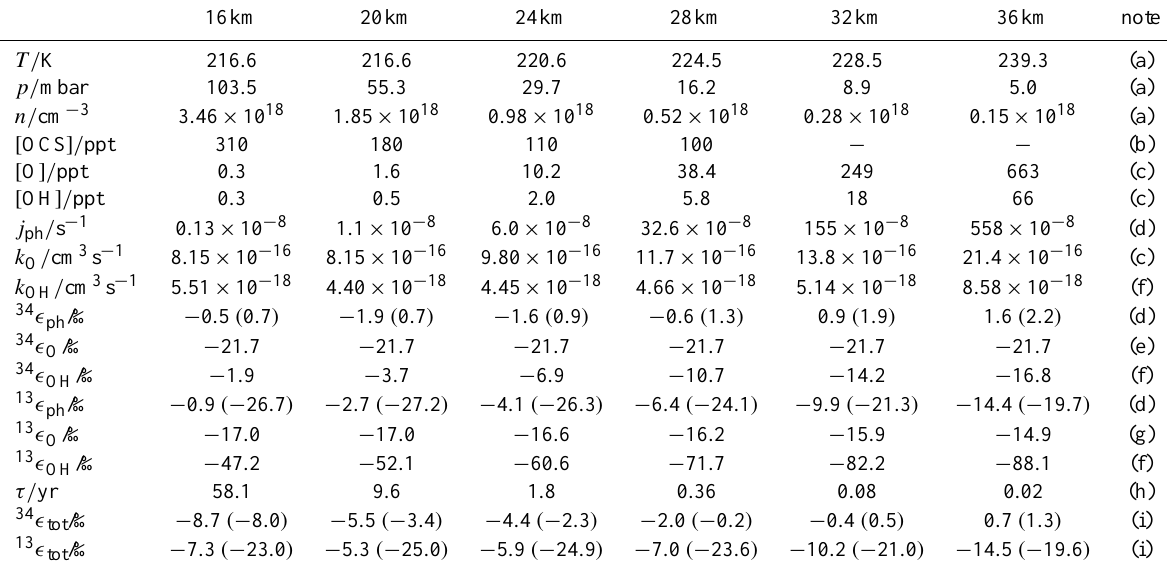
Table 2. A very simple stratospheric model. Concentrations, rate constants and fractionation constants in the upper part of the table are used to derive the total stratospheric lifetime and fraction constants in the lower part of the table. Numbers in parenthesis were calculated using the experimental cross sections of Hattori et al.